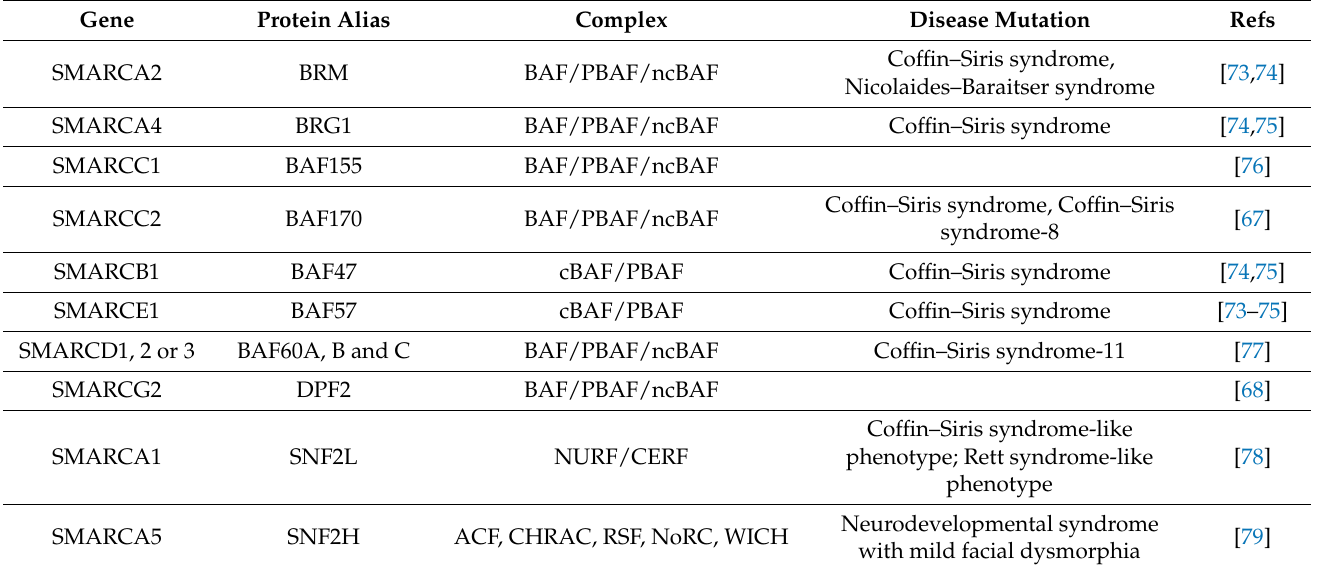
Table 2. Summary of SMARC genes present in chromatin remodelling complexes and disease- associated